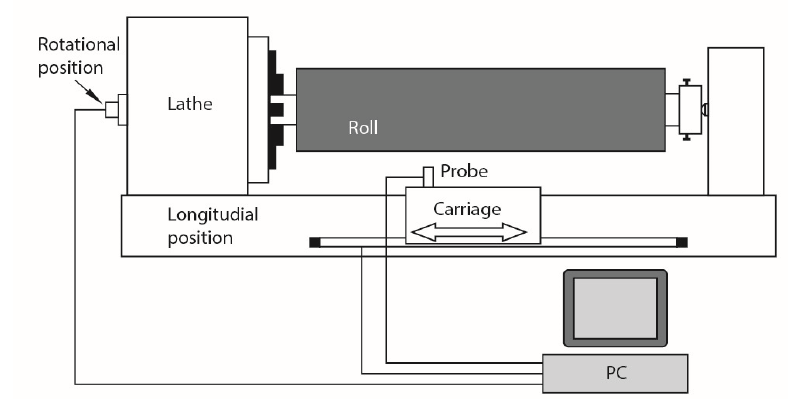
Figure 8. The thickness variation measurement setup utilizing an ultrasound probe [19].